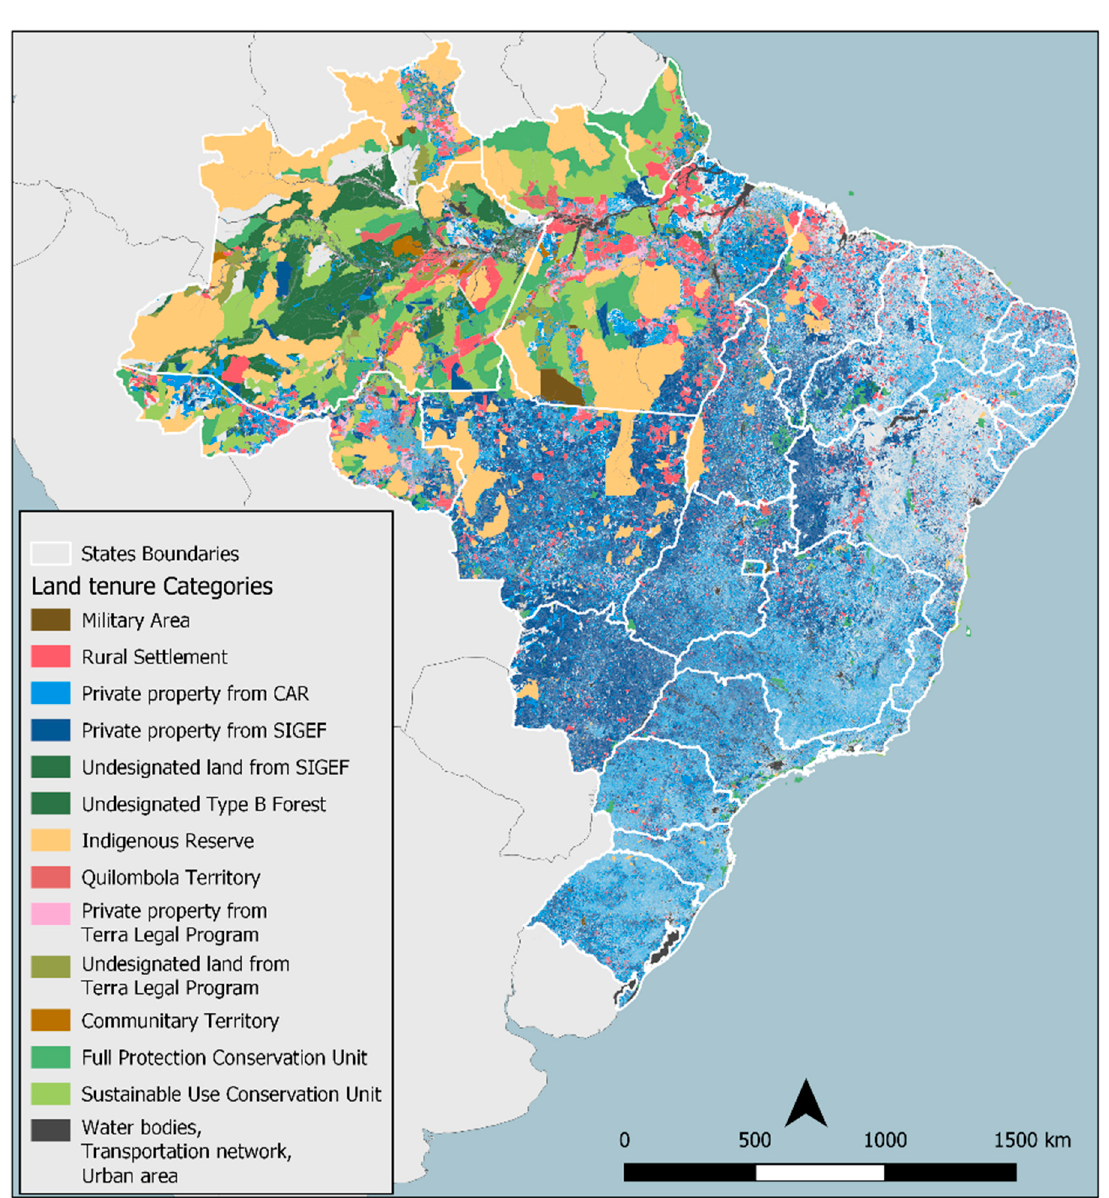
Figure 3. Reprinted with permission from Sparoveck et al. (2019) [16] from the Atlas of Brazilian Agriculture.